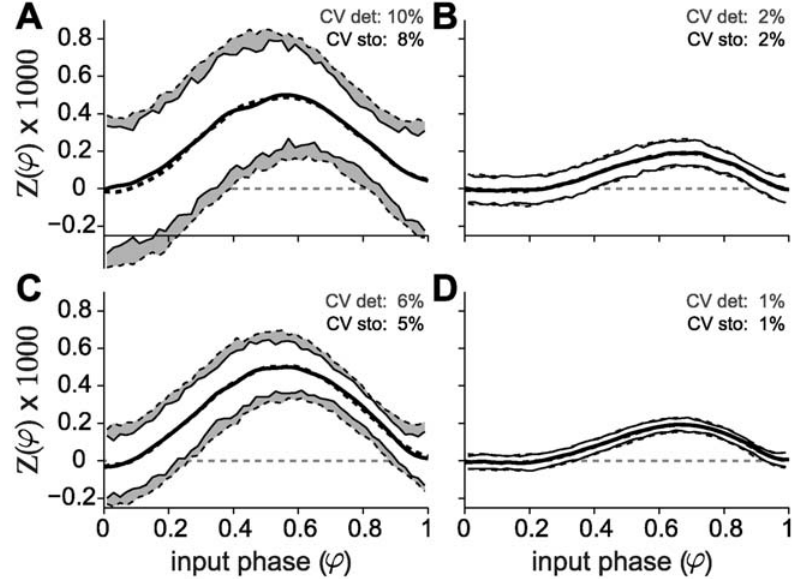
Fig 6. Stochastic channel noise is not responsible for the firing rate dependency of the PRC. The PRCs of the model incorporating channel noise (gray curves) are strikingly similar to those of the deterministic model (black curves). The variability of the spike trains does not affect the curves either at low (A and C) or high (B and D) firing rates (left and right columns, respectively). The membrane area of the model with channel noise was chosen to obtain the desired value of CV at low firing rate (around 10% for A, and 5% for C) and that same area was used for the simulations at high firing rate (panels B and D). Comparable values of CV were obtained in the deterministic model by changing the magnitude of the fluctuations of the injected current. For a given perturbation size, the model is less sensitive at high firing rates (B and